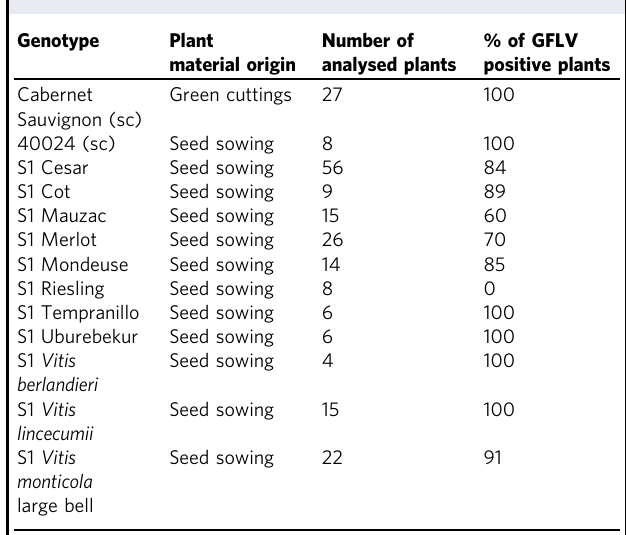
Table 1 Infection rate of 11 S1 progenies derived from grapevine varieties or Vitis species, and the susceptible controls